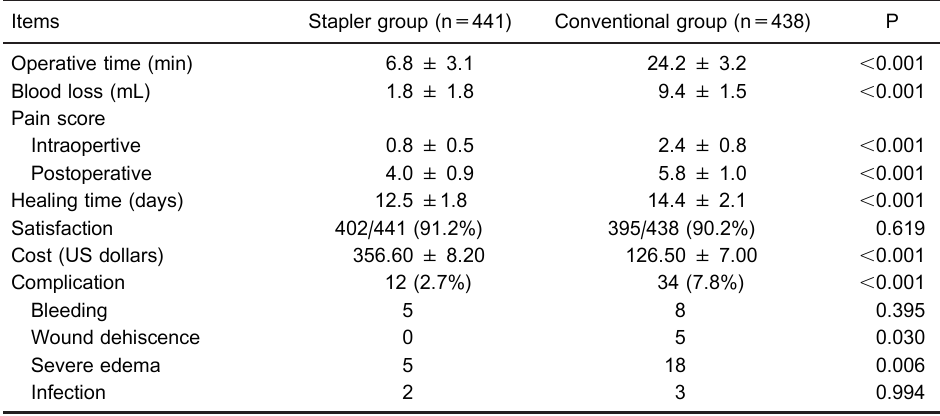
Table 2. Comparison between stapler group and conventional group.